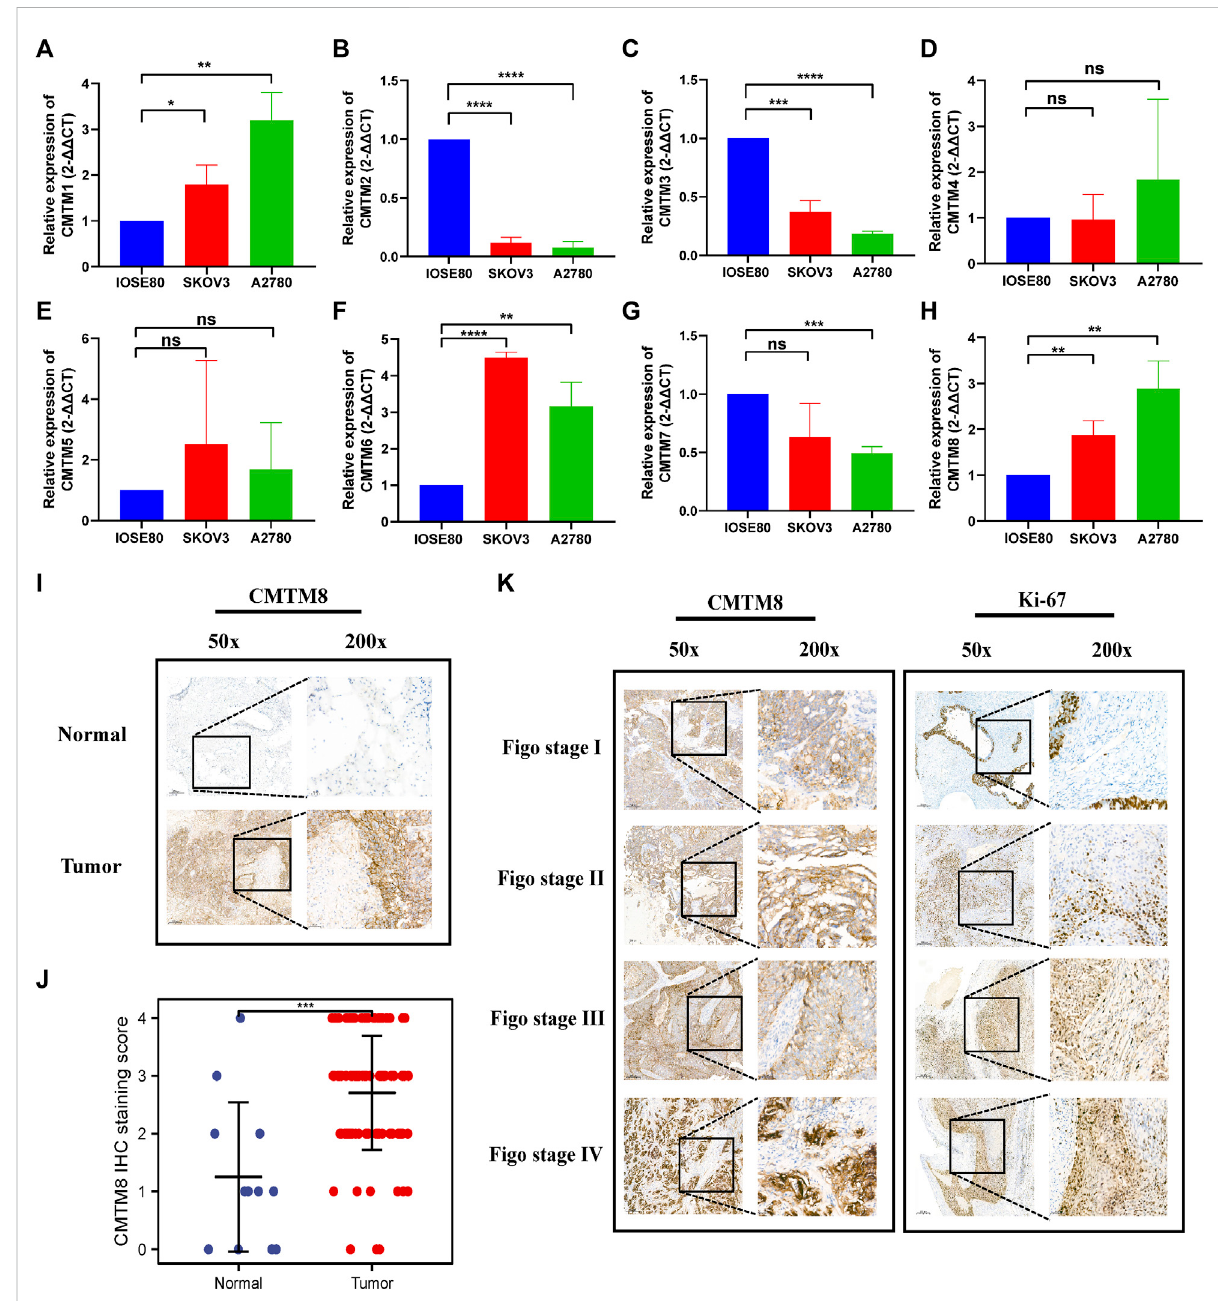
FIGURE 3 RT-qPCR and IHC was used to detect the expression of CMTM family genes in ovarian cancer and normal ovarian cell and tissues. (A – H) RT- qPCR (A) CMTM1. (B) CMTM2. (C) CMTM3. (D) CMTM4. (E) CMTM5. (F) CMTM6. (G) CMTM7. (H) CMTM8. (I) IHC of CMTM8 (J) Scatter plot of IHC stainingscoreofCMTM8 (K) IHCstainingofCMTM8andimmunohistochemistryofKi-67staining.(50xand200x,* p < 0.05;** p < 0.01;*** p < 0.001; ns = Not statistically signi fi